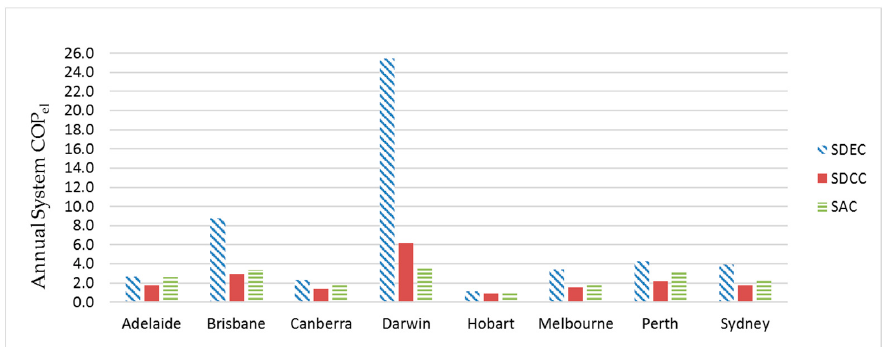
Figure 15. Annual system COP of different solar cooling systems.